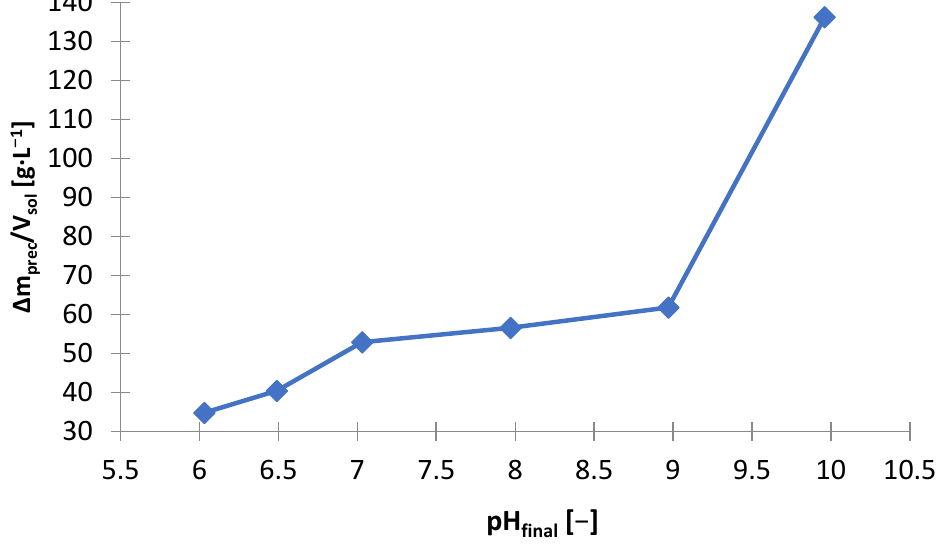
Figure 27. Effect of amount of Na 2 CO 3 (m Na2CO3 /V sol ) on final and change in pH during precipitation from solution after selective leaching.